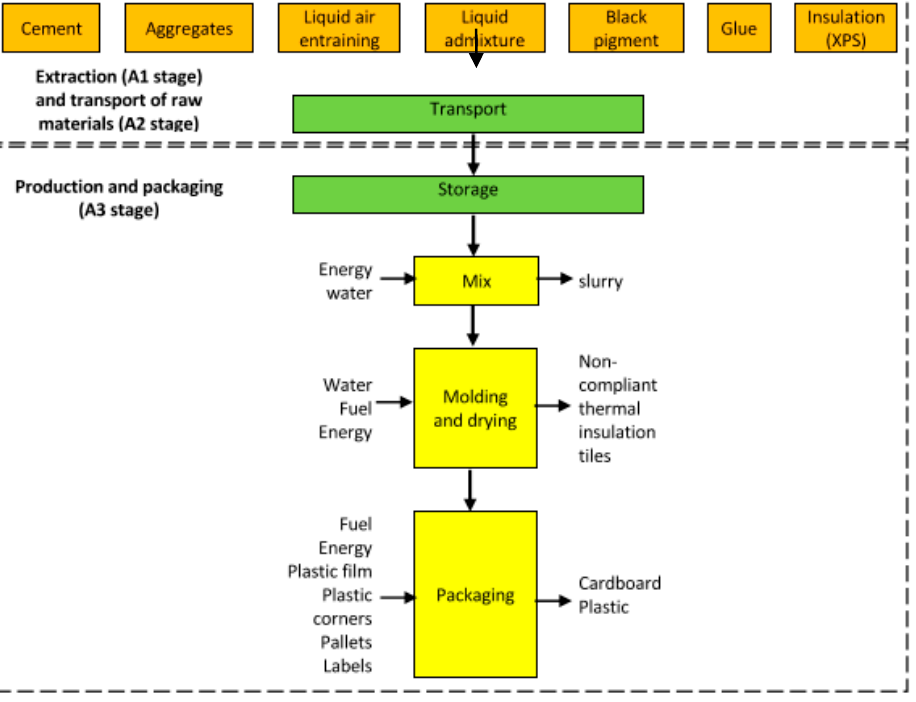
Figure 3. Key stages of thermal insulation tiles’ production and corresponding inputs and outputs.